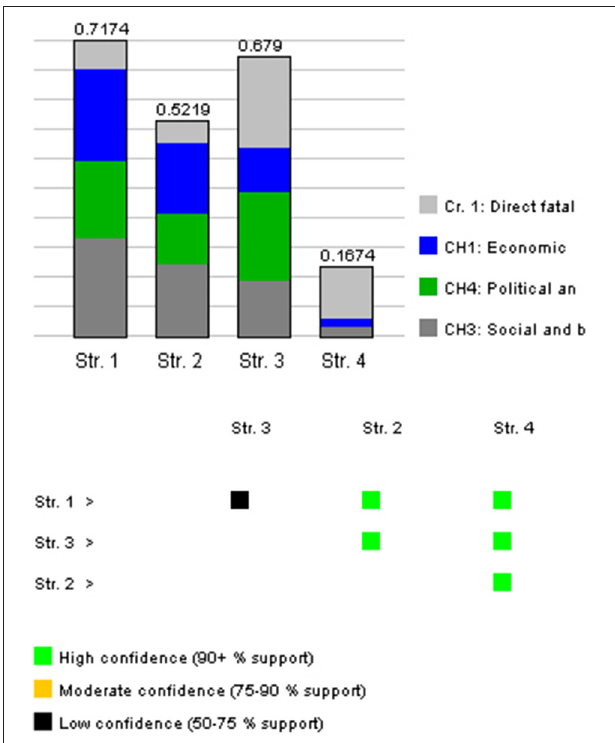
FIGURE 7 | The result of the DecideIT evaluation when all main criteria are unweighted. Conclusion: “Str. 4: L4” is the best strategy, with “Str. 1: L1” in second place. The statement Str. 4 > Str. 1 is made with low confidence since the information provided in the model supports this to a degree of